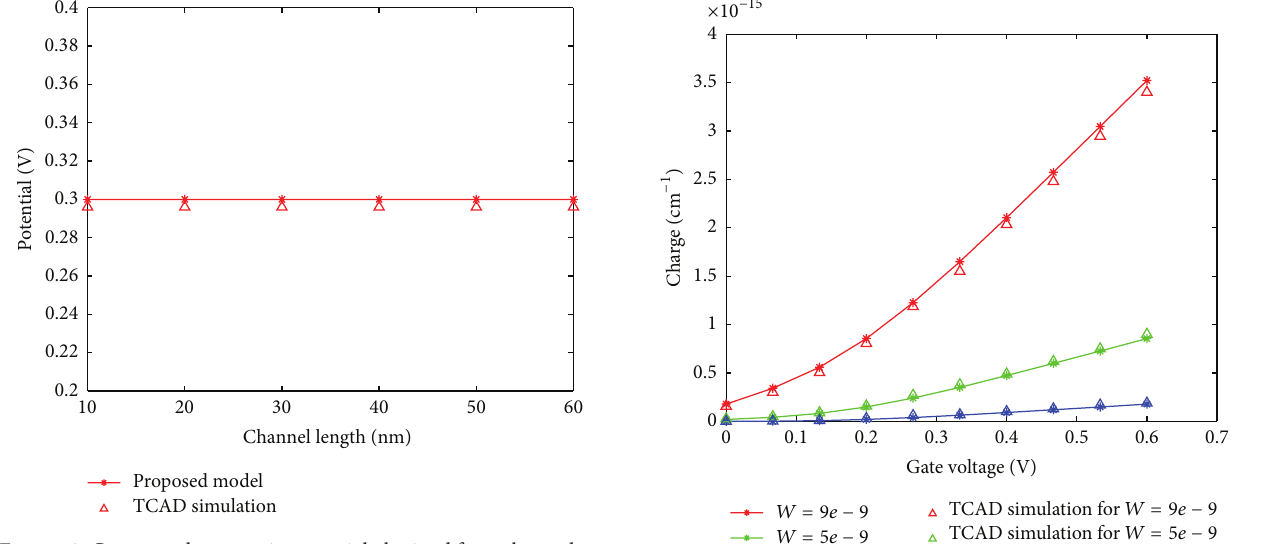
Figure 3: Constant electrostatic potential obtained from the analyt- ical solution of a gate-all-around silicon nanowire transistor is 0.3V for different channel length with a height of 𝐻 = 9 nm and channel width of 𝑊 = 9 nm. TCAD simulation shows that the potential is constant at 0.296 V.